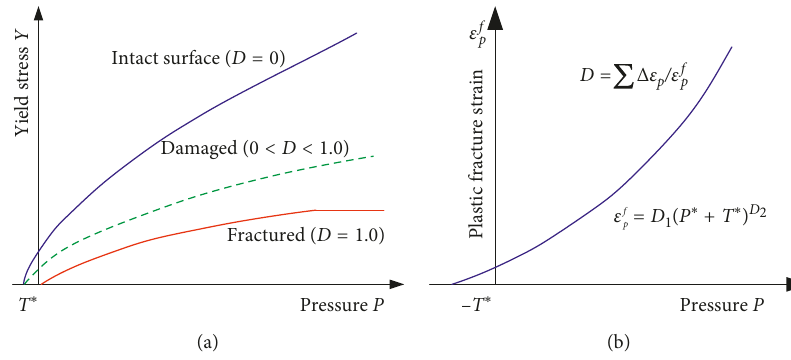
Figure 8: Equivalent strength and plastic strain versus pressure. (a) Strength model. (b) Damage model. Table 2: Rock mechanical parameters of JH2